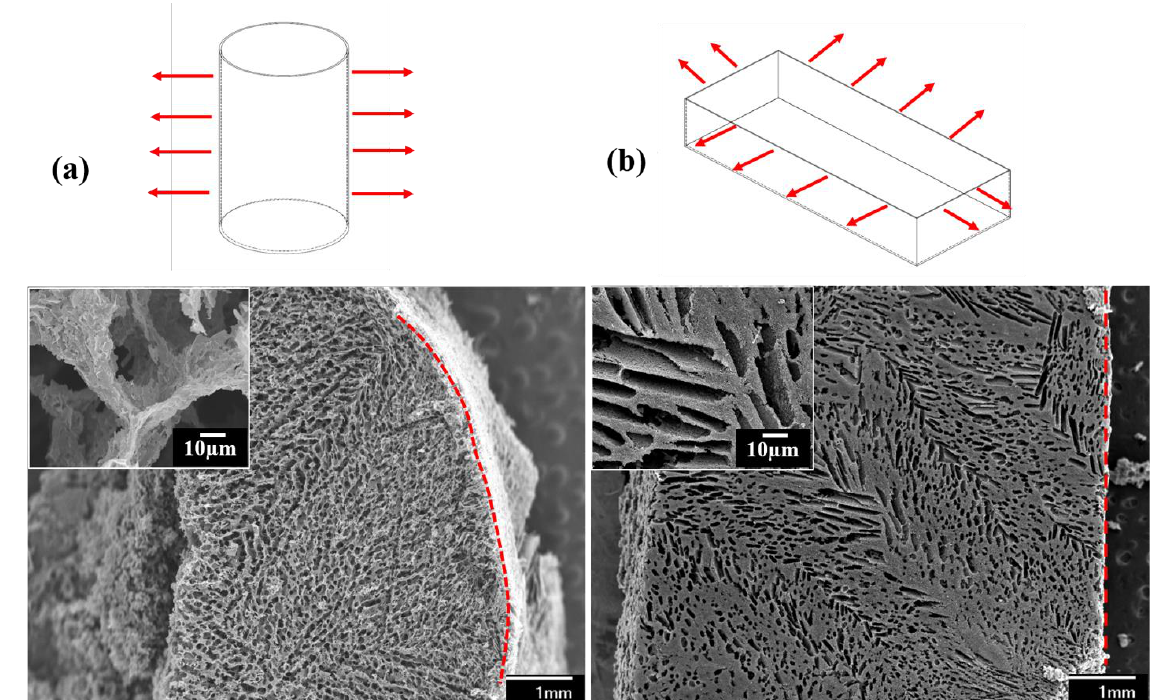
Figure 7. ( a ) 3D GNP foam produced in a cylindrical mold (20 mm in length, 10 mm in diameter and mold thickness of 0.16 mm); and ( b ) 3D GNP foam made in a rectangular mold (50 mm in size, 20 mm in width, 10 mm in height diameter, and mold thickness of 0.16 mm). Both insets show the wall thickness (8 wt.% GNP slurry used in both the molds).